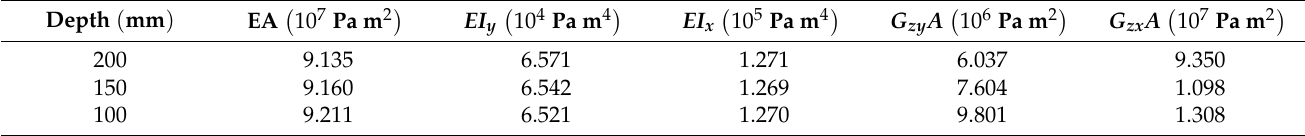
Table 1. Effective stiffness of the Z profile with a 5 mm mesh depending on the elongation (beam axis). (cid:0) Depth ( mm ) EA 10 7 Pa m 2